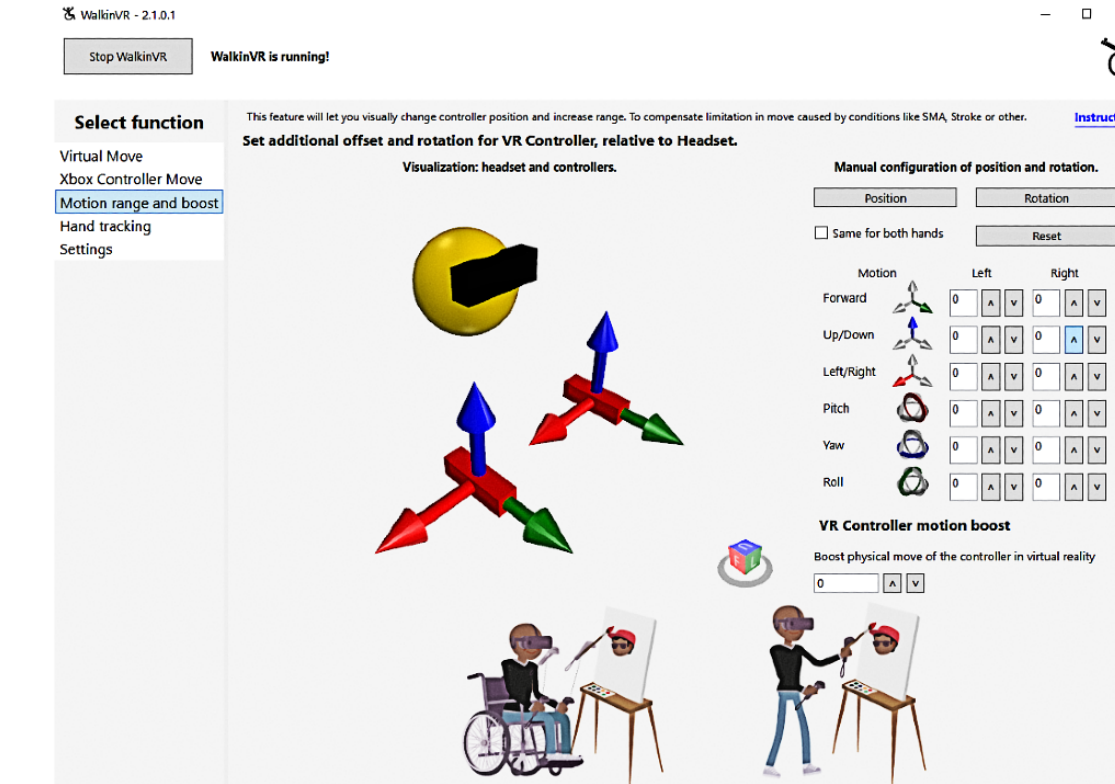
Figure 1. Screenshot of the WalkinVR motion range and boost.